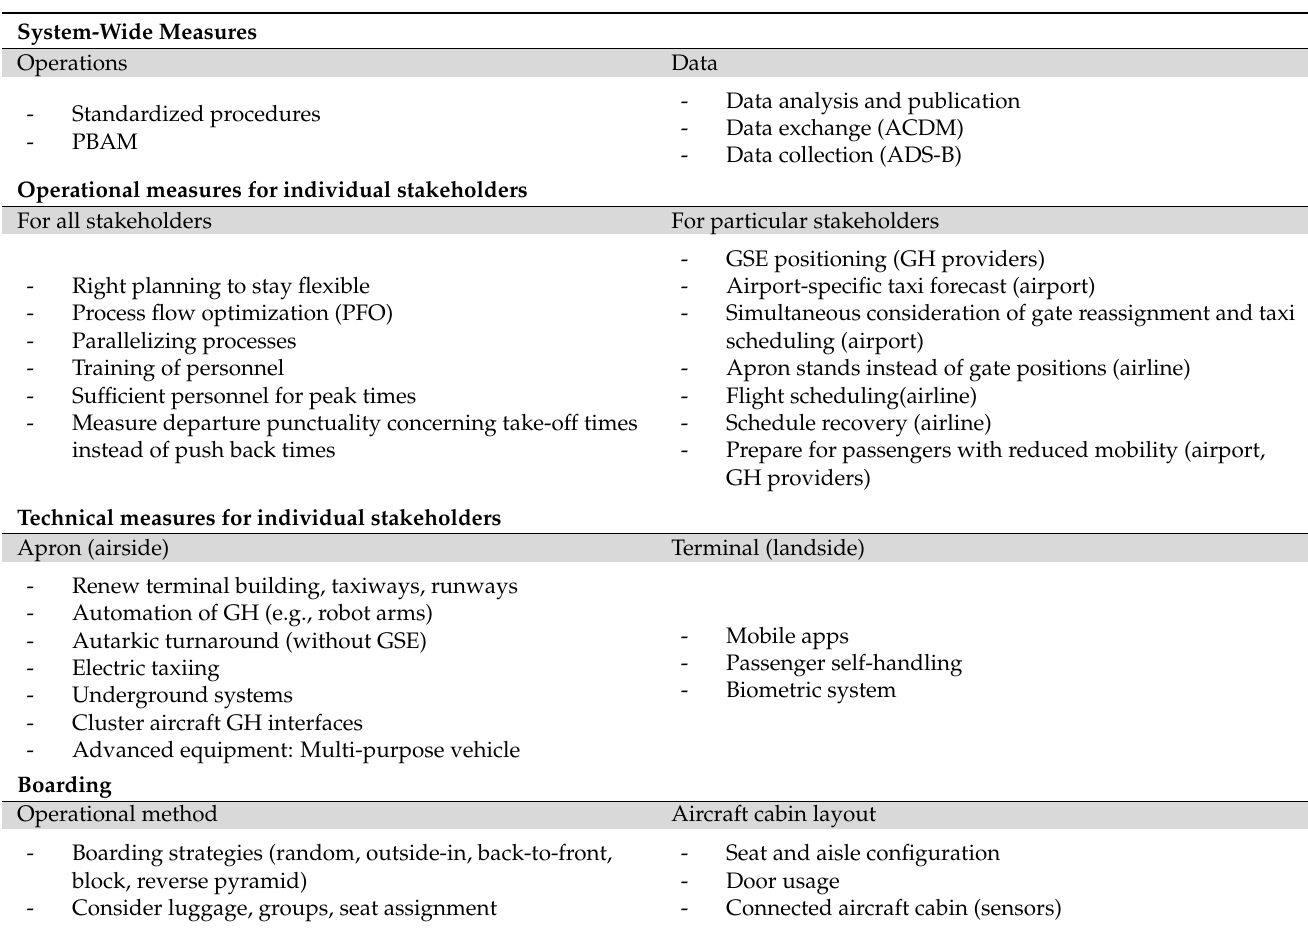
Table 2. Overview of considered measures to reduce ground times in passenger air